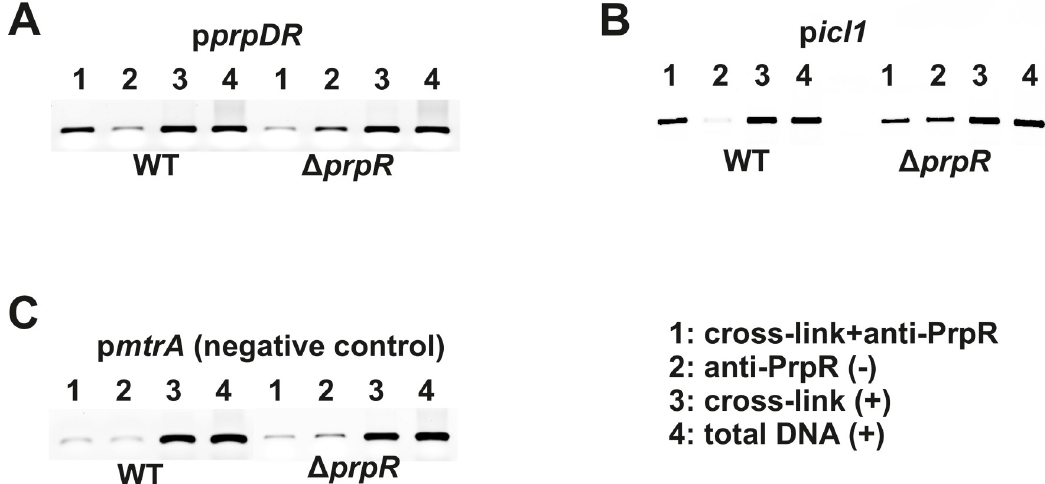
Fig 4. PrpR binds the promoter region of prpDC and icl1 genes in intact M . tuberculosis cells. Identification of intracellular PrpR-DNA complex using immunoprecipitation. PrpR-DNA complexes cross-linked with glutaraldehyde were immunoprecipitated with anti-6HisPrpRMt polyclonal antibodies (sample 1). PCR was carried out with the primer pairs, p1129_Fw and p1129_Rv ( pprpDR )(A);picl_Fw and picl_Rv ( picl1 )(B); and pmtrA_Fw and pmtrA_Rv ( pmtrA , negative control)(C). Negative control (2) consisted of DNA template extracted from the cells subjected to immunoprecipitation, but nucleoprotein complexes were not previously cross-linked. Positives controls (+) were also performed using template obtained from strains subjected only to cross- linking (3) or total DNA extracted from the cells